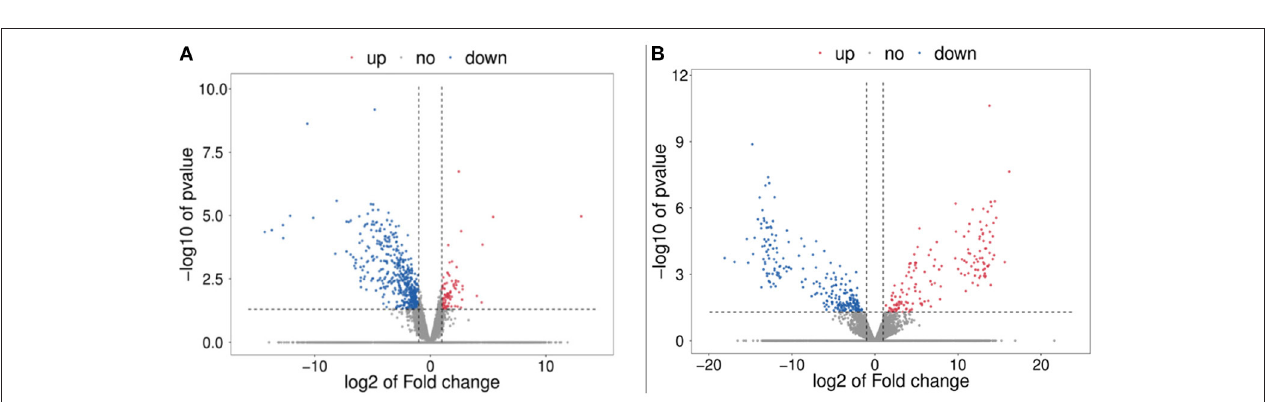
FIGURE 4 | Volcano plot of the differential expression of mRNAs and lncRNAs in pig ovaries between control group and treatment group. (A) Differential expression of mRNAs. The blue points denote significantly downregulated mRNAs, while the red points denote significantly upregulated mRNAs. (B) Differential expression of lncRNAs. The blue points denote significantly down-regulated lncRNAs, while the red points denote significantly upregulated lncRNAs.